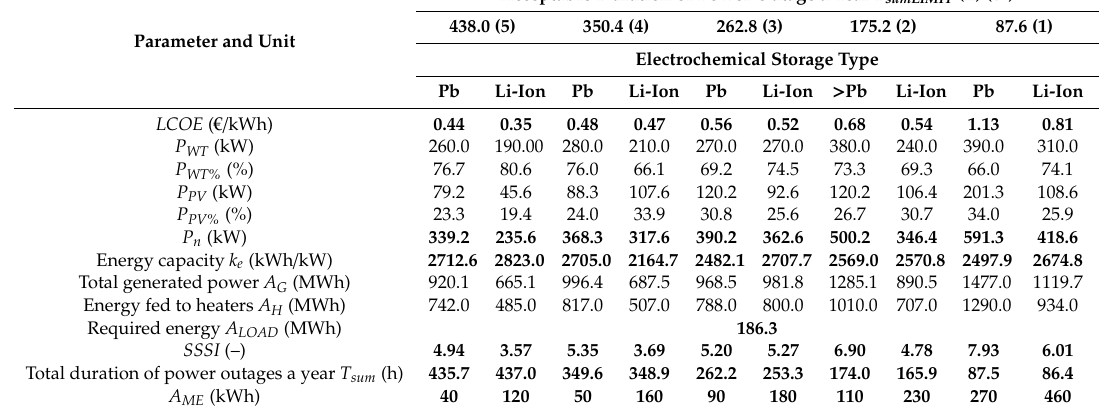
Table 3. Results of PV-wind hybrid power supply system structure optimization (lead-acid and lithium-ion battery) for a 50 kW peak power of a communal load with no limit for the power generation